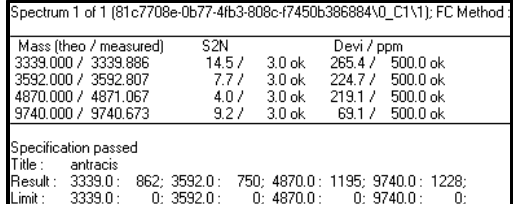
Figure 6. Result of FlexAnalysis algorithm for B. anthracis species. If all the characteristic ion peaks are found in the experimental spectrum considered, the specification is passed and the correct and unambiguous identification at species level is possible.